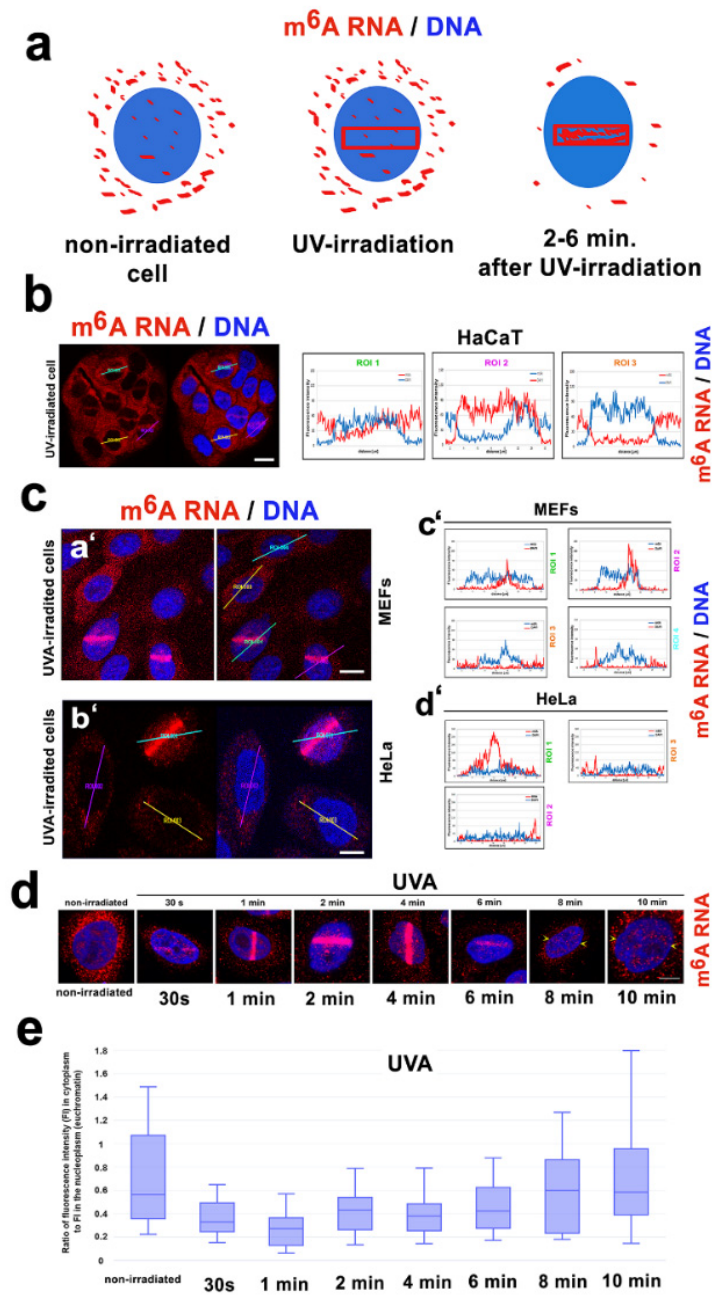
Figure 2. In microirradiated cells, m 6 A RNA di ff used from the cytoplasm to the cell nucleus. ( a ) A pictorial illustration of m 6 A RNA distribution in the cytoplasm and the cell nucleus. The red frame in panel ( a ) shows the selected genomic region exposed to local laser microirradiation. ( b ) The distribution of m 6 A RNAs in the human keratinocytes (HaCaT cell line) with physiological genomes. ( c ) m 6 A RNAs in ( a’ ), ( c’ ) wild-type MEFs and ( b’ ), as well as ( d’ ) cervical carcinoma HeLa cells. Cells were exposed to laser microirradiation. Quantification of the fluorescence intensity of the Alexa 594-stained m 6 A RNAs was performed using LAS X software. Scale bars represent 15 µ m. Di ff usion of m 6 A RNA from the cytoplasm to the cell nucleus exposed to ( d ), local laser microirradiation. Scale bars show 5 µ m. DAPI (blue) was used as a counterstain. HeLa cells were used for these experiments. Panel ( e ) shows the quantification of the fluorescence intensity in microirradiated ROIs. This analysis was performed by LAS X software connected to a Leica laser-scanning confocal microscope.